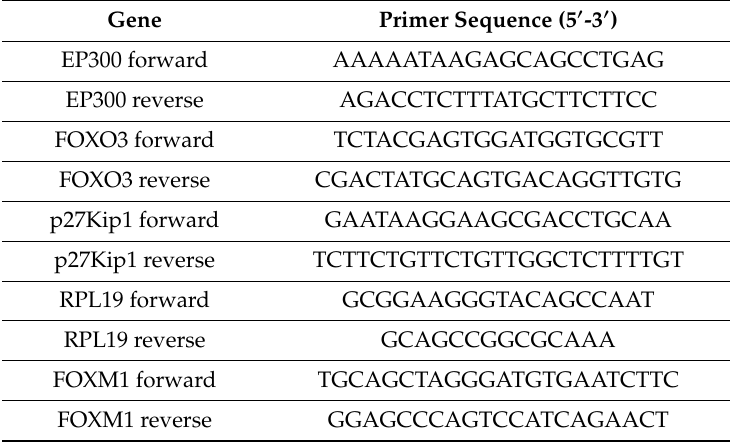
Table 1. Forward and reverse primer sequences used for RT qPCR. Gene Primer Sequence (5 (cid:48) -3 (cid:48)